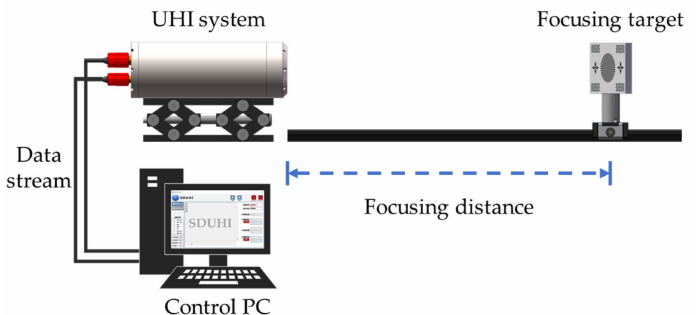
Figure 7. Schematics of the experimental setup for the autofocus test. The autofocus calibration to establish the look-up table in order to obtain the transfer factor.